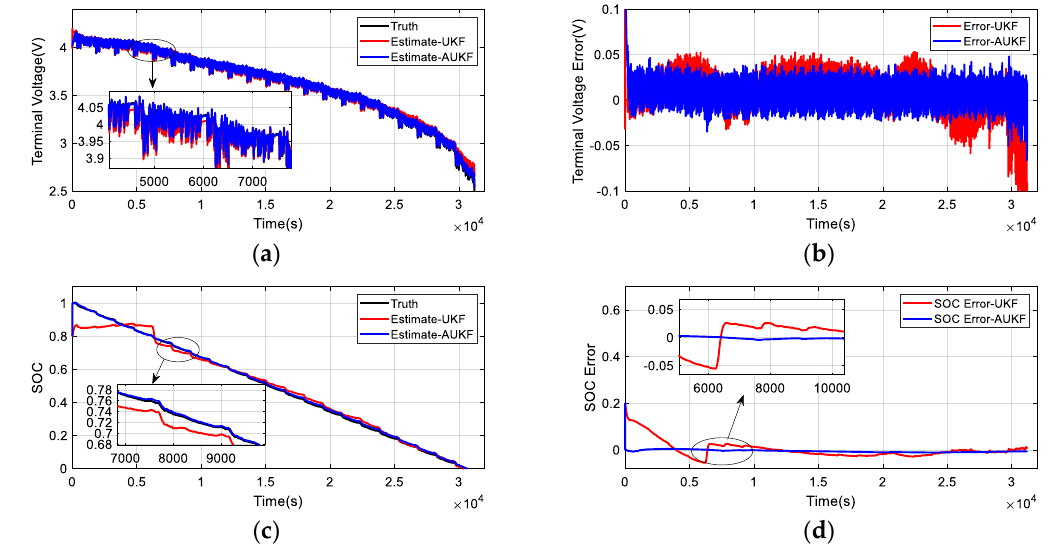
Figure 19. For the initial SOC = 0.8, the comparison of the estimation results of the UKF algorithm and the AUKF algorithm under UDDS discharge conditions. ( a ) Comparison of terminal voltage. ( b ) Comparison of terminal voltage errors. ( c ) Comparison of SOC. ( d ) Comparison of SOC errors.